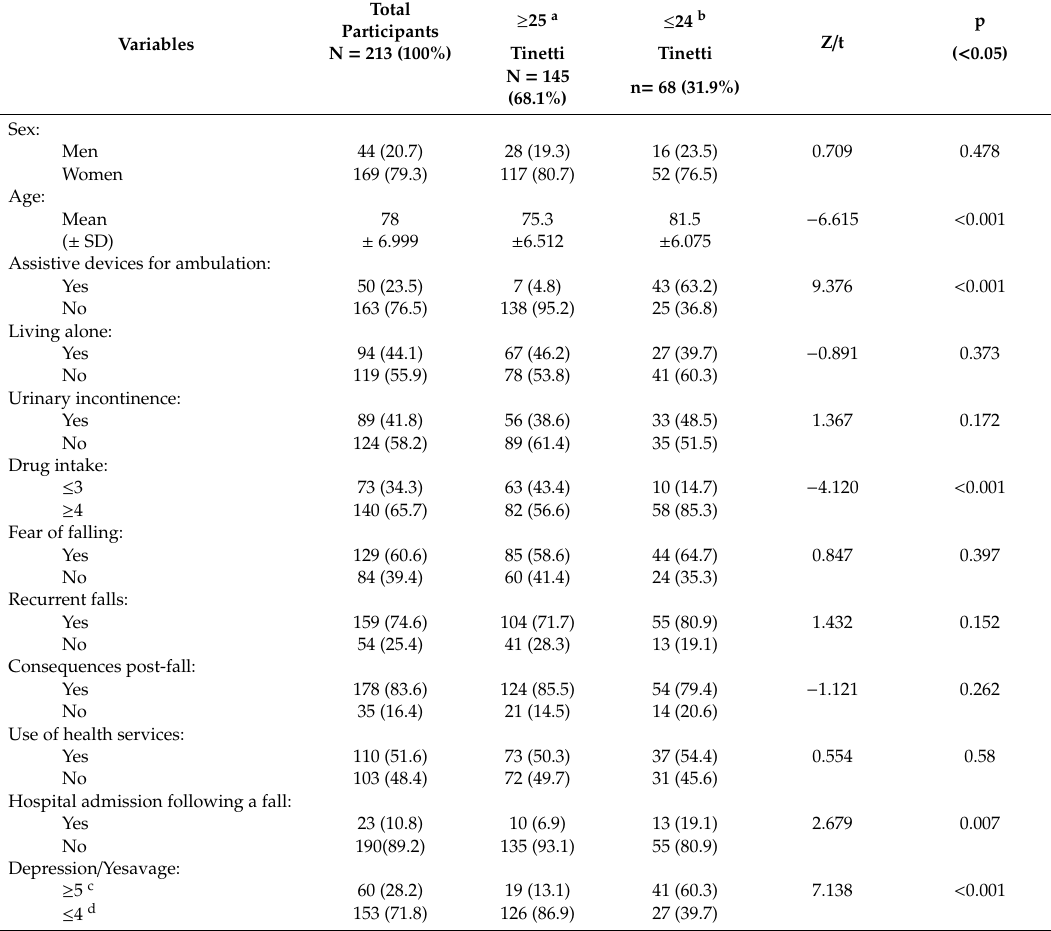
Table 1. Univariate and bivariate analysis for risk of falls (Chi-square and independent t-test). Variables